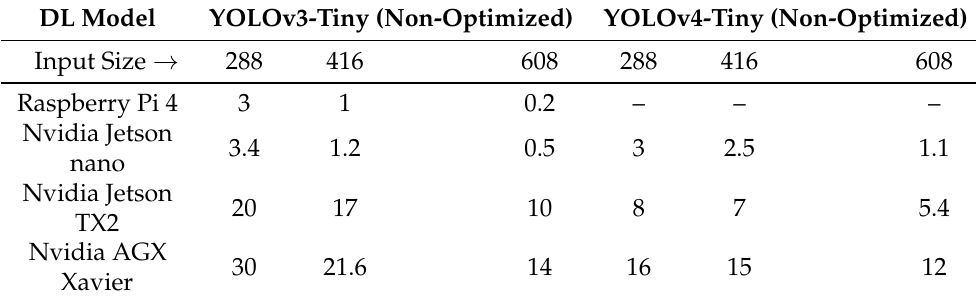
Table 2. FPS on different scales of images during real-time detection (YOLOv3-tiny and YOLOv4-tiny without weight optimization).